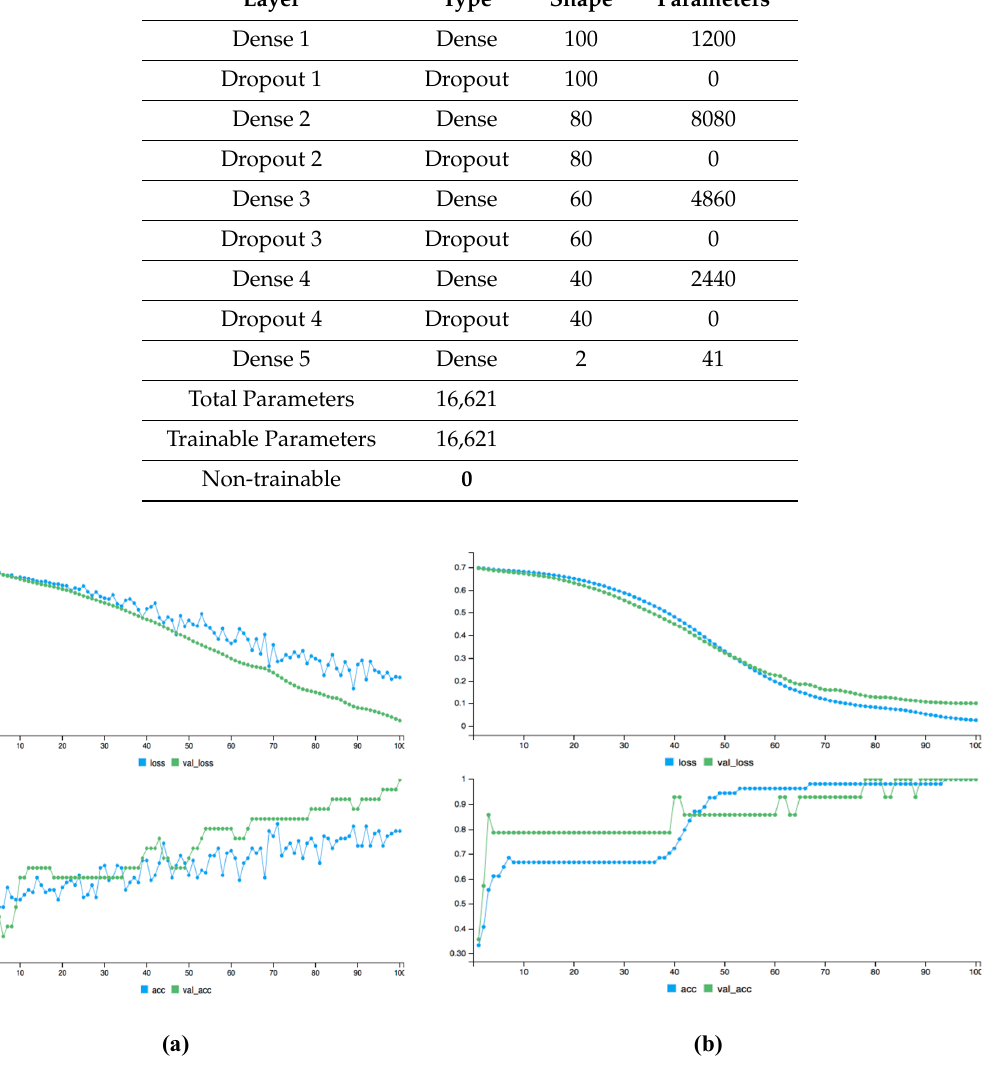
Figure 7. Dynamic visualization of predicted loss and accuracy with 100 epochs. ( a ) Accuracy and Loss without Class balancer and Fine-tune. ( b ) Accuracy and Loss with Class balancer and